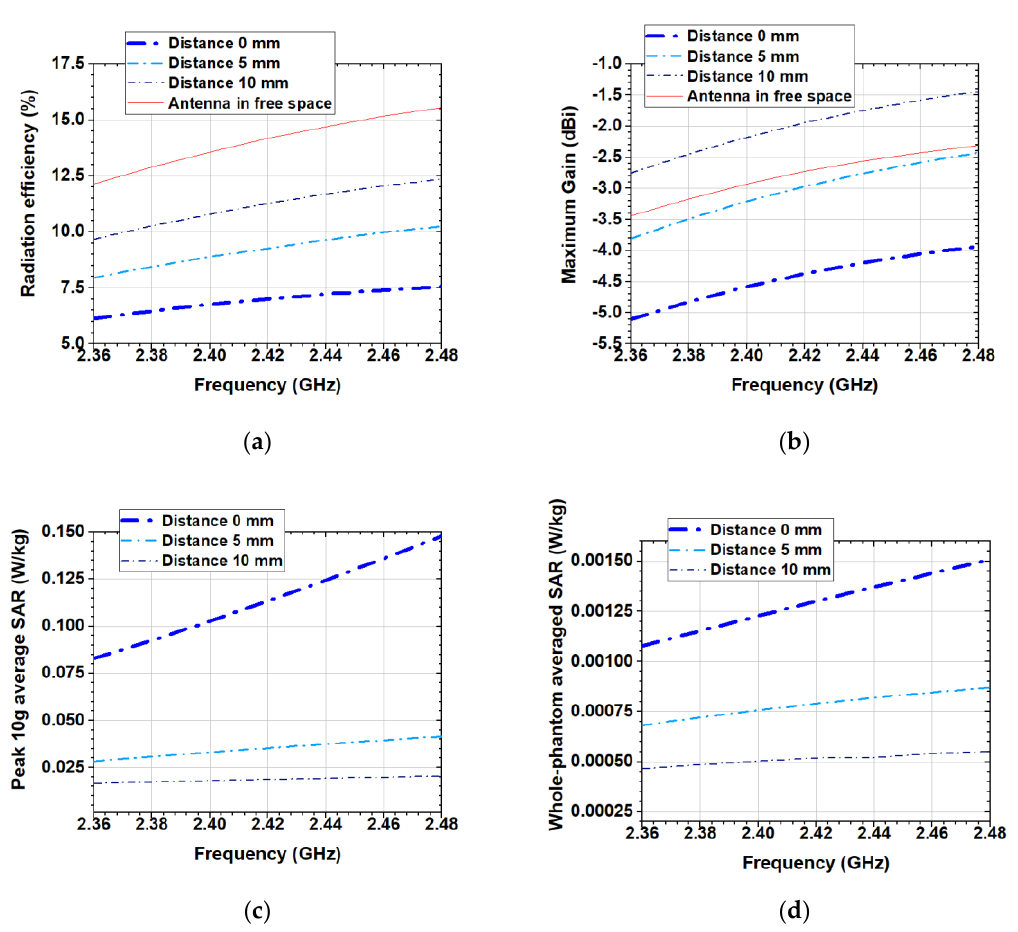
Figure 5. Simulated: ( a ) Radiation efficiency; ( b ) Maximum gain; ( c ) peak 10 g average SAR; ( d ) whole-phantom averaged SAR at distances 0 mm, 5 mm and 10 mm between the antenna and the human body model.